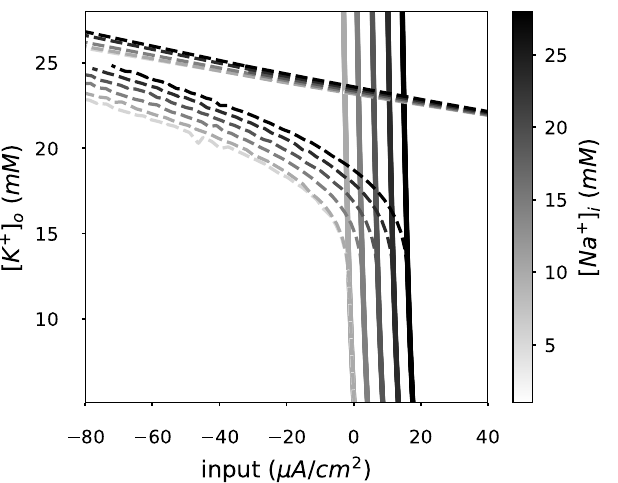
Fig 6. Extracellular-potassium- and intracellular-sodium-dependent bistable area. Same bifurcation diagram portrayed in Fig 3 for different intracellular sodium concentrations [ Na + ] to transition from resting to spiking regimes. [ Na + ] i accumulation shifts the bistable region to higher current